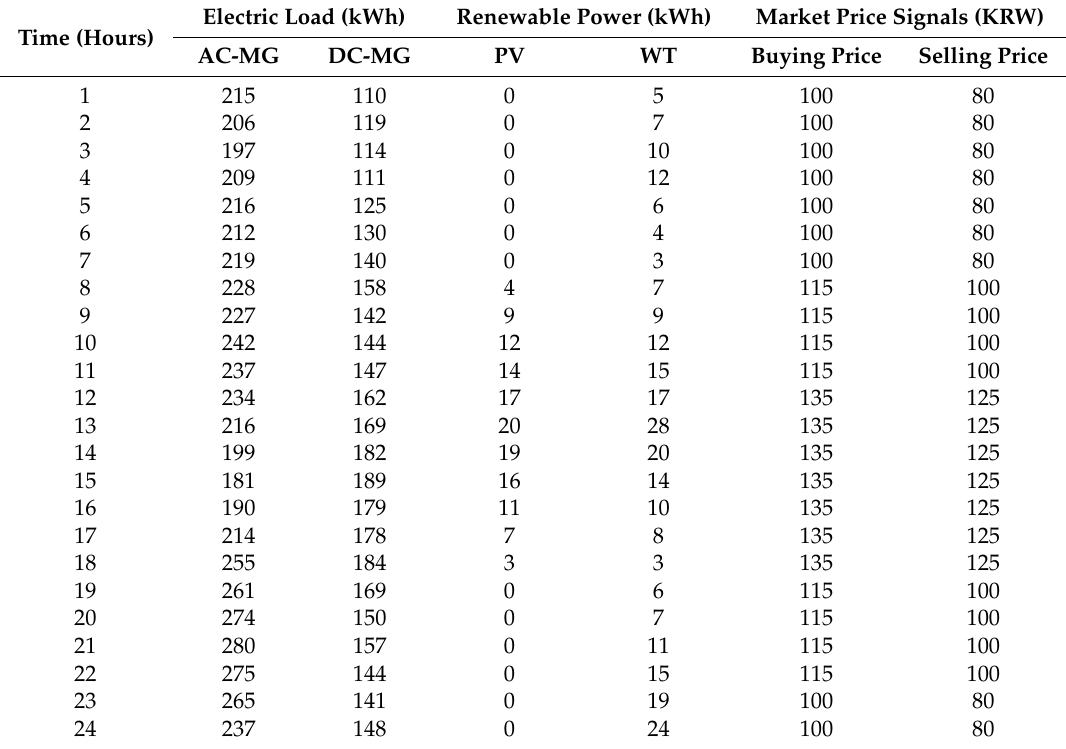
Table 1. Forecasted values of load and renewable generations along with the market price.